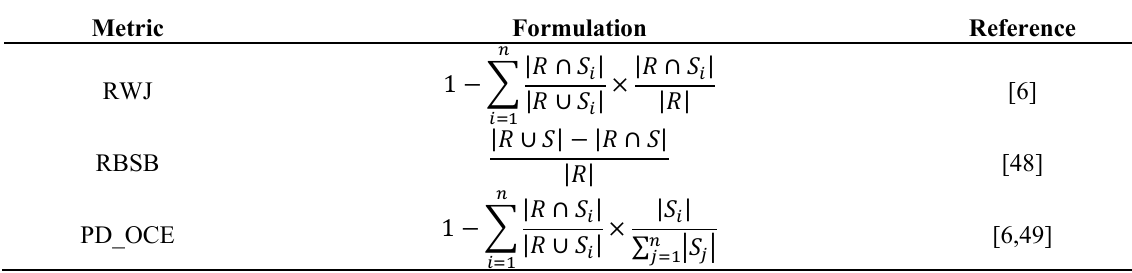
Table 1. The three empirical discrepancy metrics employed to measure the quality of generated segments against the provided reference